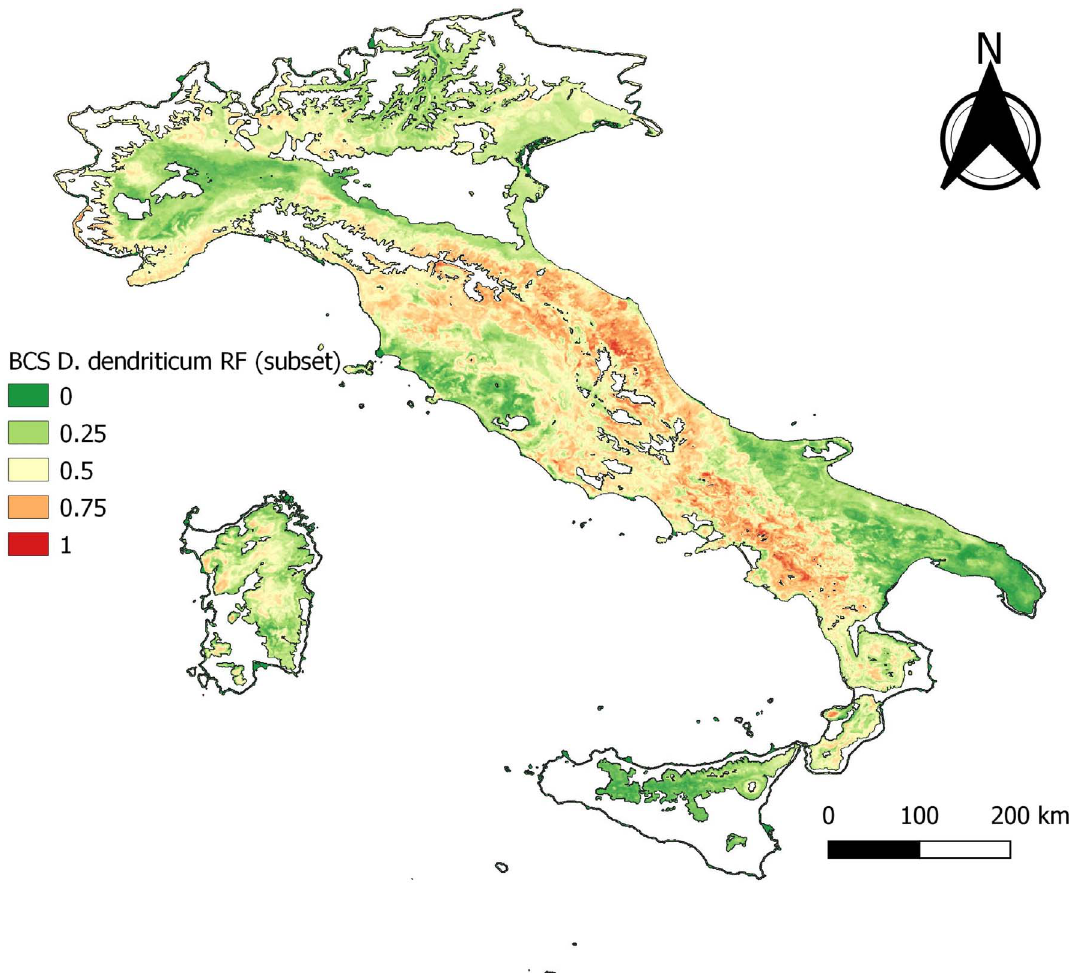
Figure 4. Baseline model,